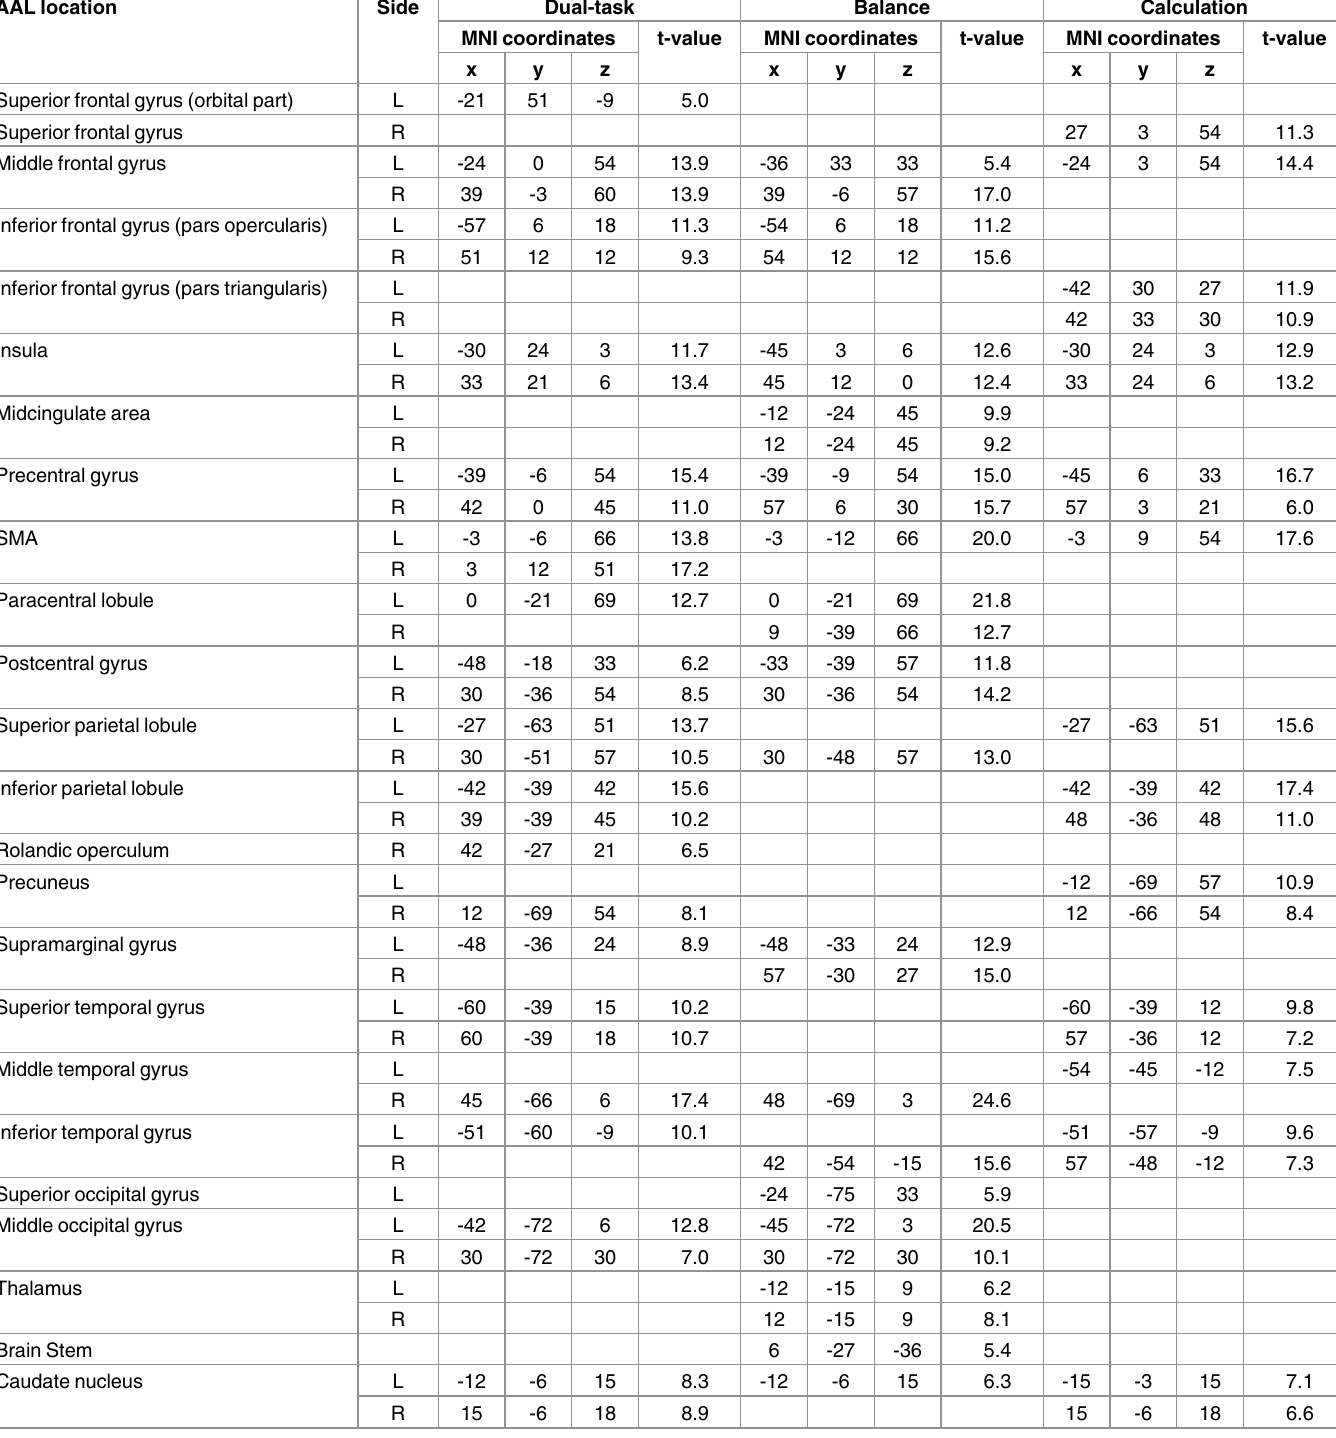
Table 2. MNI coordinates and t-values of the local maximawith significant activation during balance, calculation and dual-tasking (p < 0.05; FWE corrected for multiple comparisons). Voxel size is 3x3x3 mm. AAL